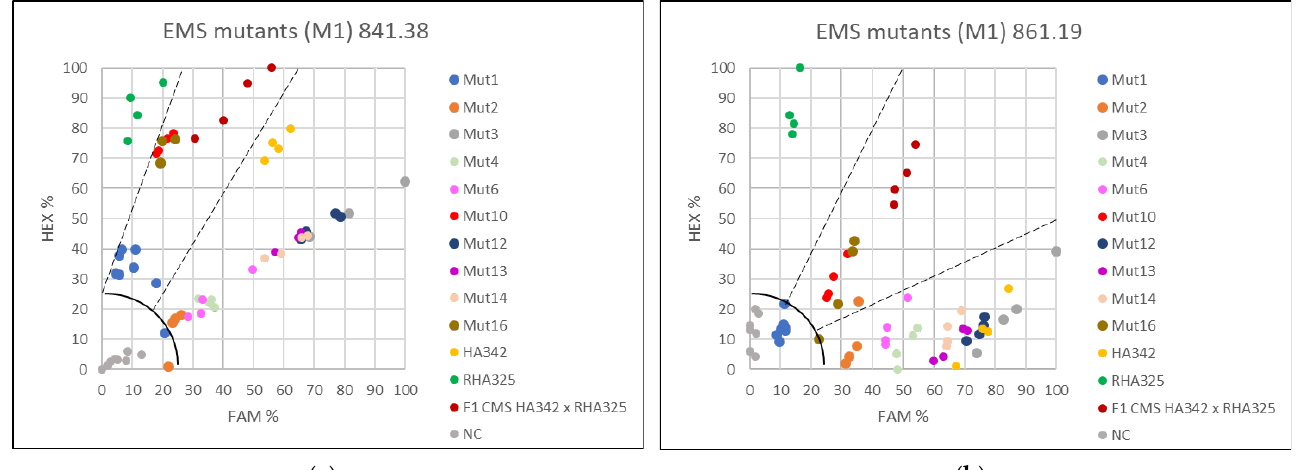
date genes. Single plant KASP assays allowed classifying each plant into a group, either